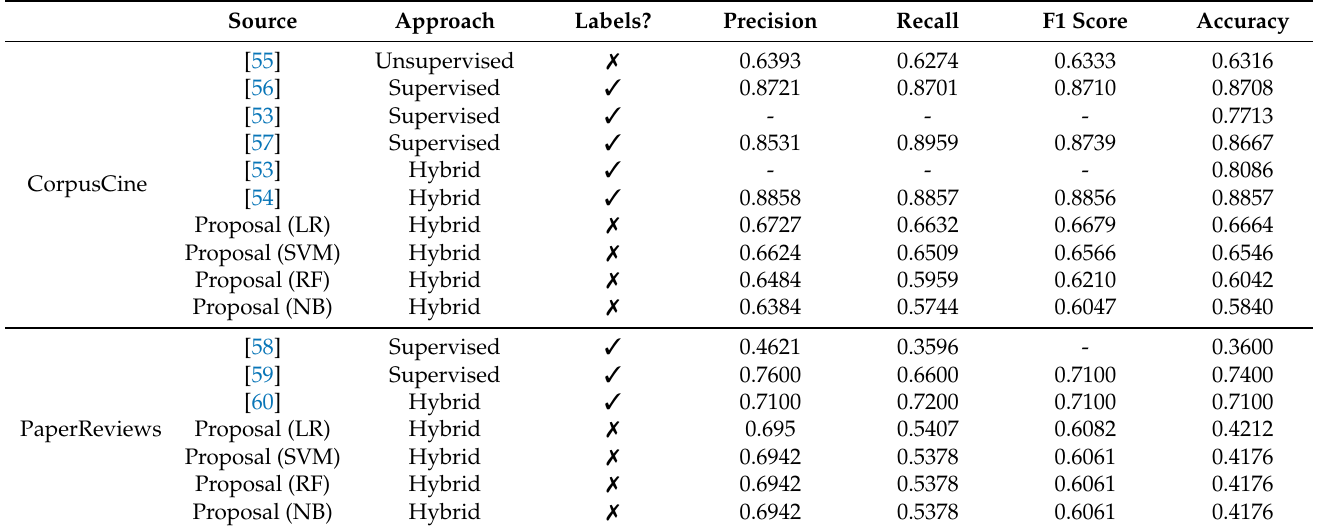
Table 6. Performance of our hybrid approach using four different classification algorithms and compared with state-of-the-art approaches. LR: Logistic Regression, SVM: Support Vector Machine, RF: Random Forest, NB: Naive